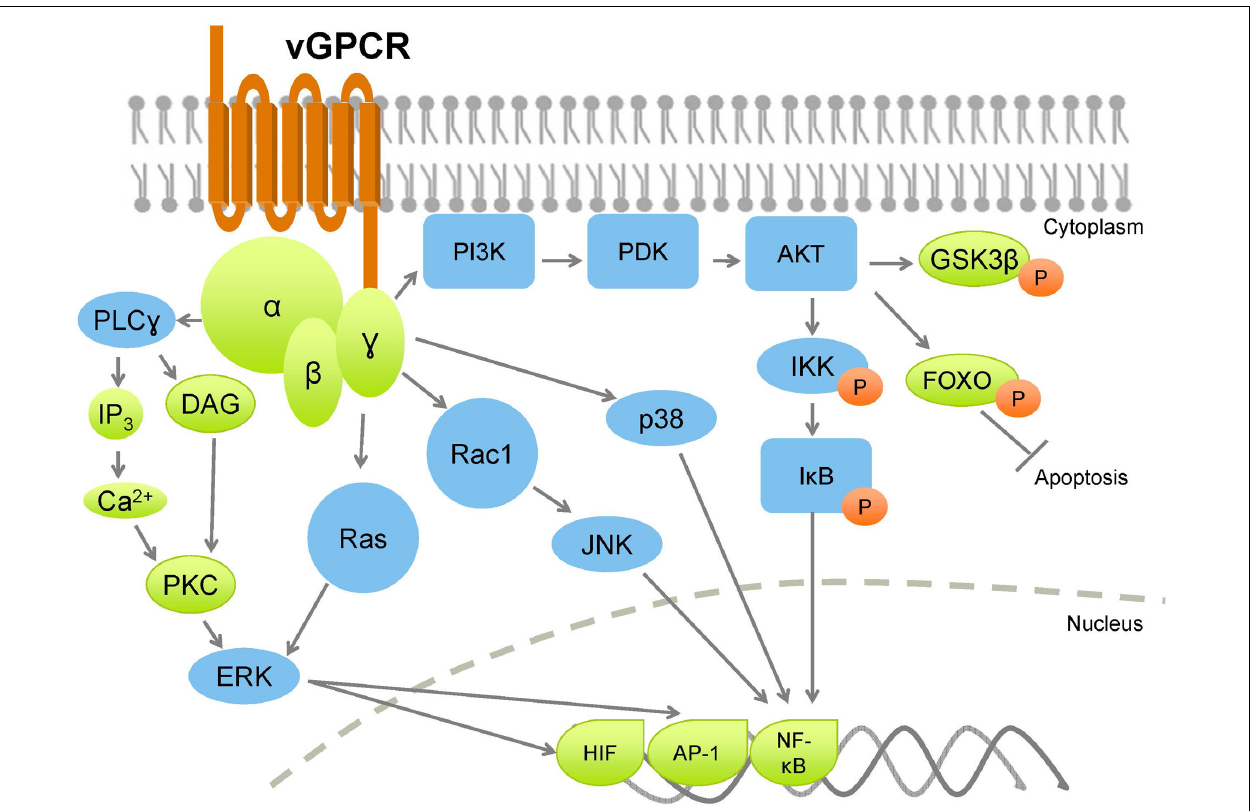
FIGURE 2 | Kaposi sarcoma-associated herpesvirus vGPCR broadly activates PI3K and MAPK pathways, leading to increased production of cytokines and growth factors, with a concurrent increase in cell proliferation, and inhibition of apoptotic pathways. Orange circles denote